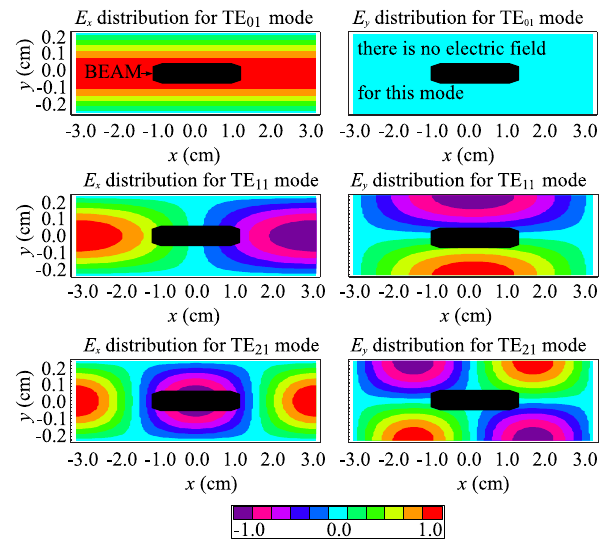
FIG. 12. The field distributions of TE and the beam initial position are